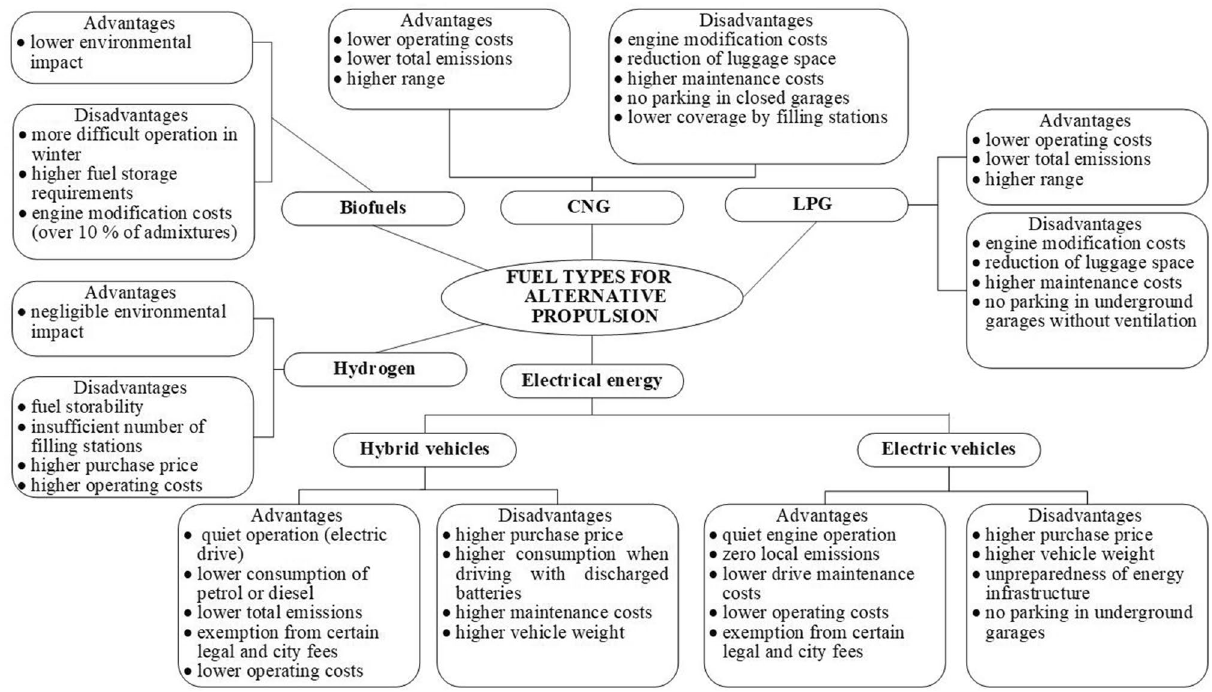
Figure 4. Advantages and disadvantages of alternatively powered passenger cars compared to conventional